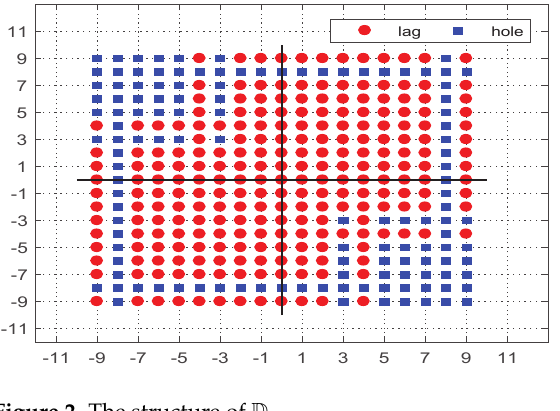
Figure 2. The structure of D